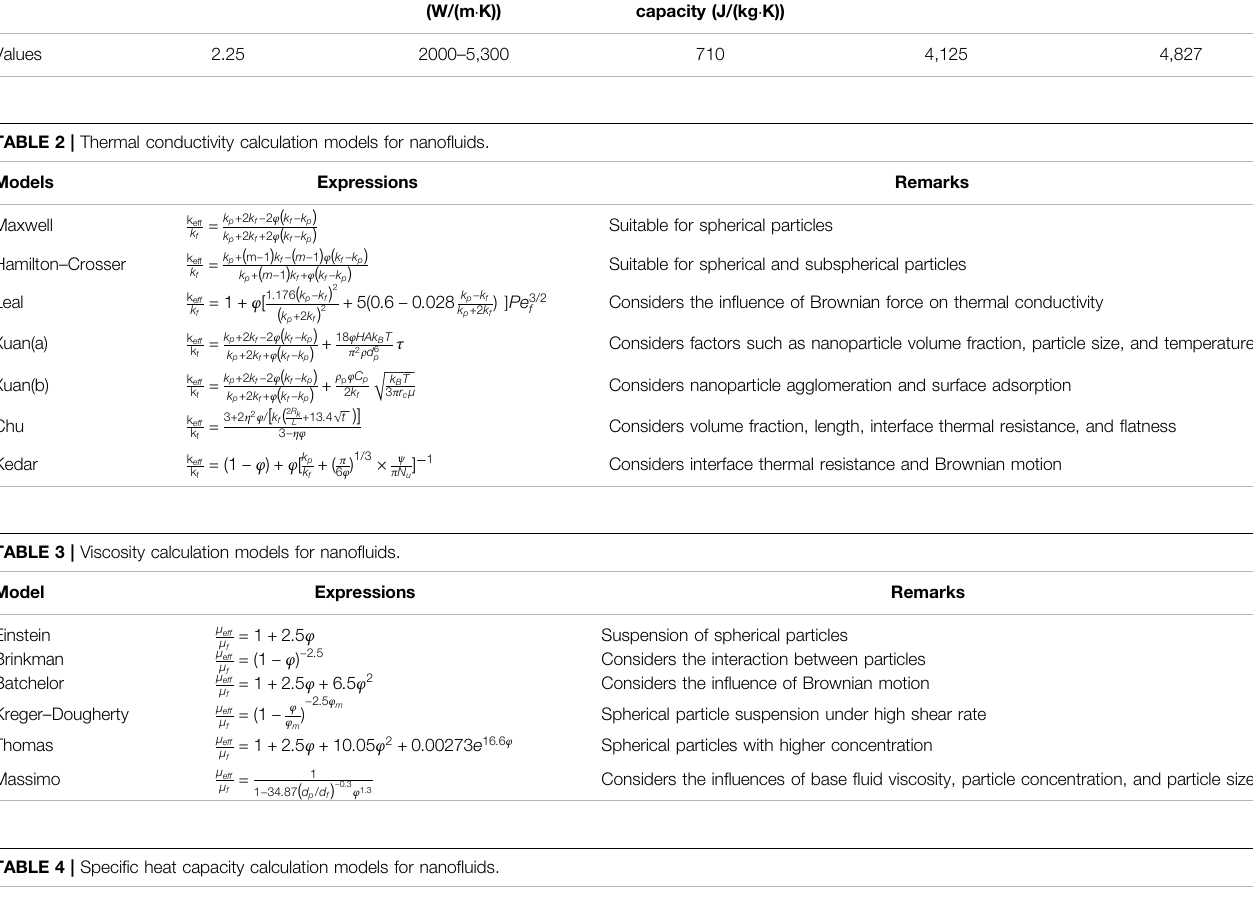
TABLE 1 | The properties of graphene nanoparticles. Properties